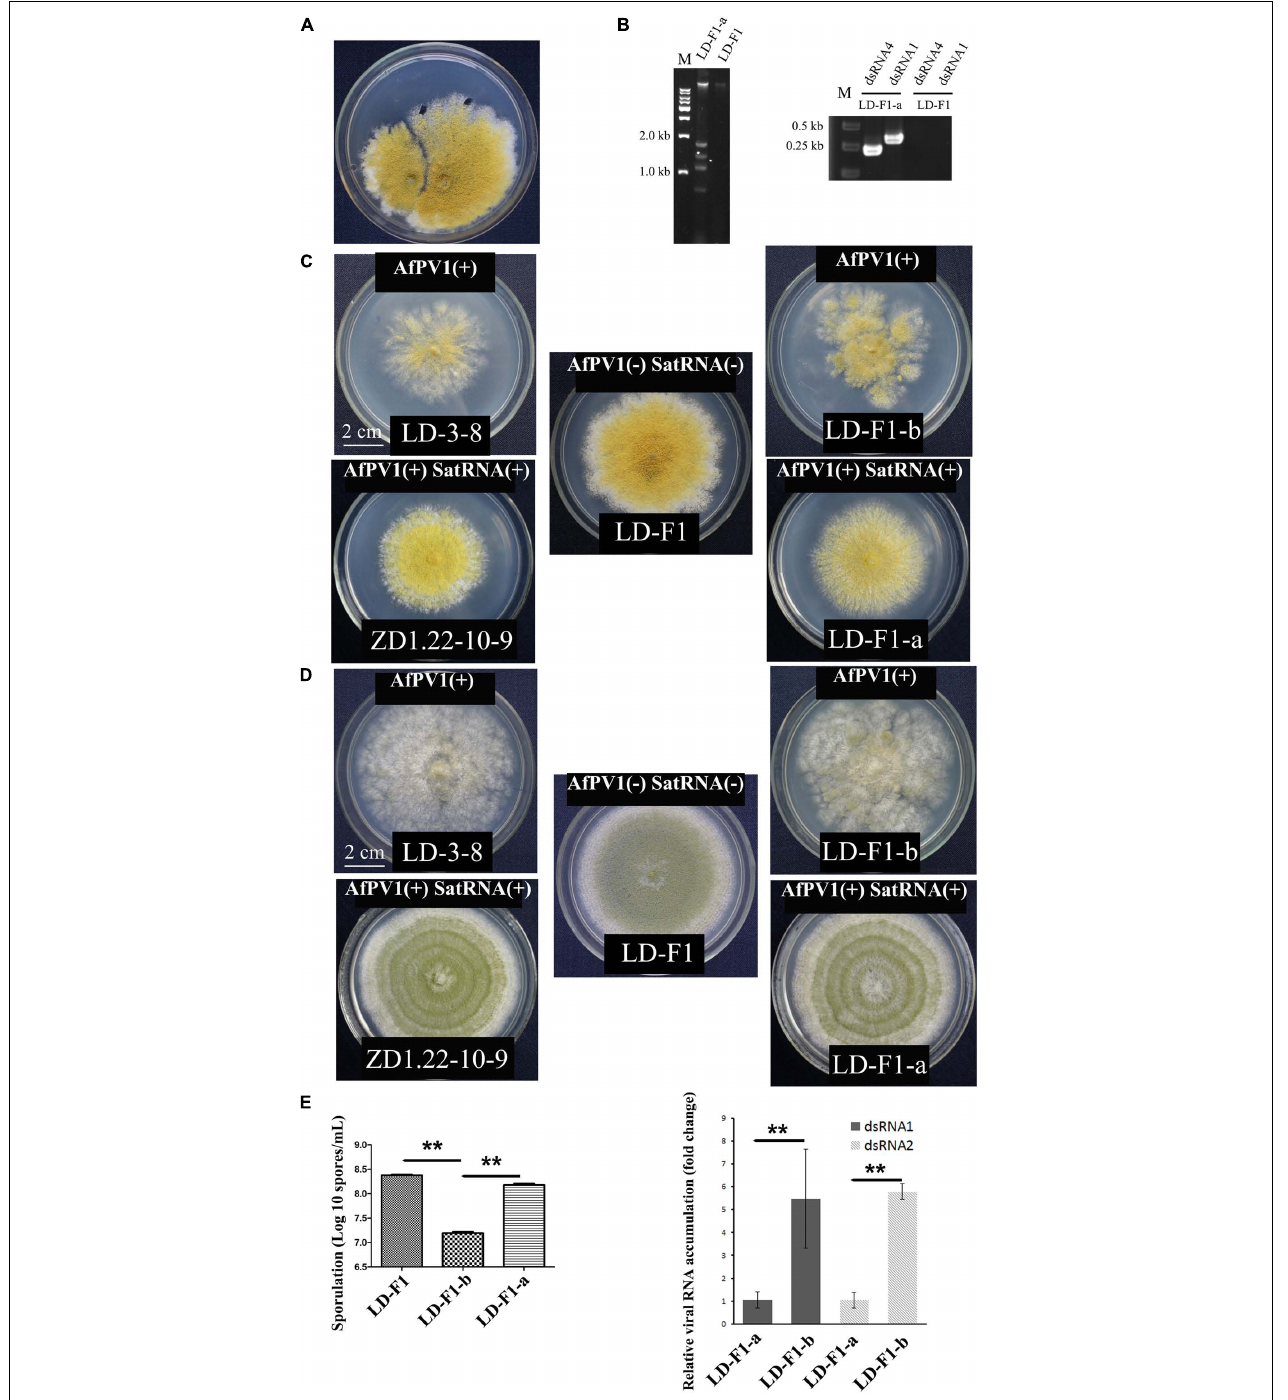
FIGURE 2 | Effects of AfPV1 and satellite RNA in A. flavus. (A) Paired-cultures between the donor isolate ZD1.22-10-9 (left) and the virus-free recipient isolate LD-F1 (right). Derivative isolates were obtained from the mycelial agar plugs of LD-F1. (B) Agarose gel electrophoresis of dsRNA extracted from derivative isolates (left), and RT-PCR detection for AfPV1 and satellite RNA (right). Colony morphology of isolates LD-3-8, ZD1.22-10-9, LD-F1, LD-F1-a, and LD-F1-b after culturing on CZ (C) and PDA (D) for 6 days. (E) Sporulation of isolates LD-F1, LD-F1-b, and LD-F1-a (left). The accumulation of AfPV1 in isolates LD-F1-a and LD-F1-b (right). Isolate LD-3-8 was infected with AfPV1, virus-free isolate LD-F1 was obtained from isolate LD-3-8 by single sporing, and then was labeled with a pyrithiamine resistance ( ptr ) gene, and isolate LD-F1-b was one of the derivative isolates, obtained by transferring AfPV1 from isolate LD-3-8 (donor) to the virus-free isolate LD-F1 (recipient). Isolate ZD1.22-10-9 was infected with AfPV1 and satellite RNA, while isolate LD-F1-a was one of the derivative isolates, obtained by transferring AfPV1 and satellite RNA from isolate ZD1.22-10-9 (donor) to the virus-free isolate LD-F1 (recipient). * P < 0.05, ** P < 0.01, *** P < 0.001, by Tukey’s multiple comparison tests.